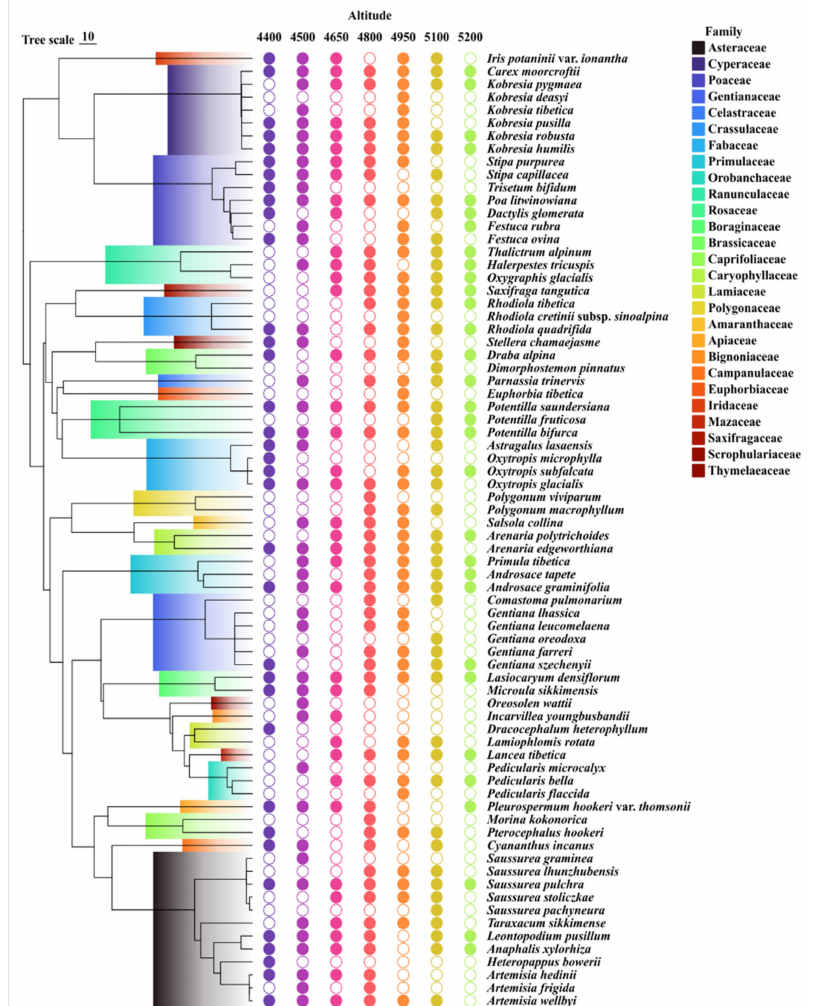
Figure 1. The phylogenetic distribution of all plants in this study. Different colored circles indicate species that occur at different altitudes, blank circles indicate absence, and solid circles indicate presence during the survey. The different colors of the branches correspond to different families in the